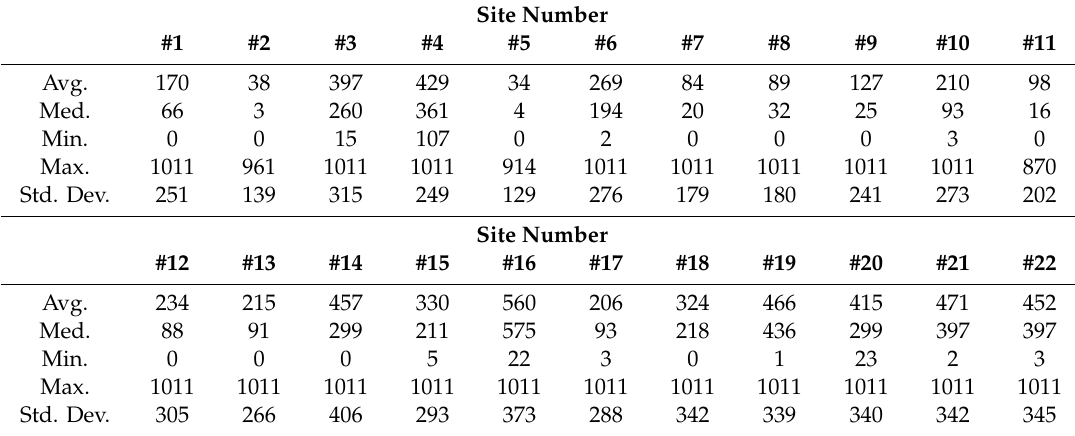
Table 3. Descriptive statistics of E. coli concentration (CFU per 100 mL) at each sampling location (n = 22) during the study period (2 January 2018–1 January 2019) in West Run Watershed, WV,